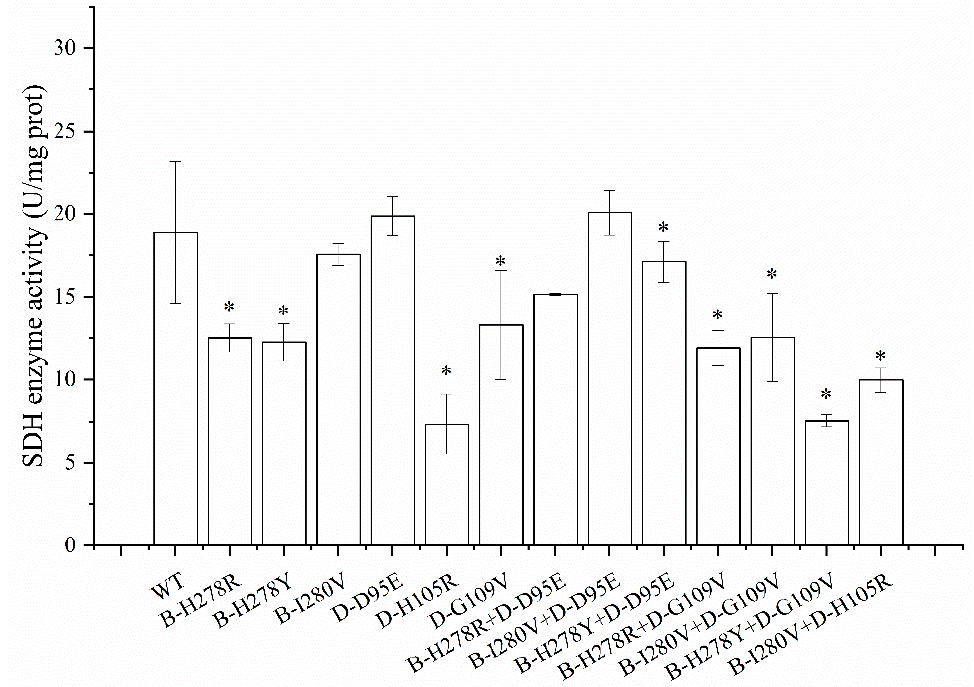
Figure 6. SDH activity of single or and double mutation. * indicates significant differences compared with WT ( p < 0.05).